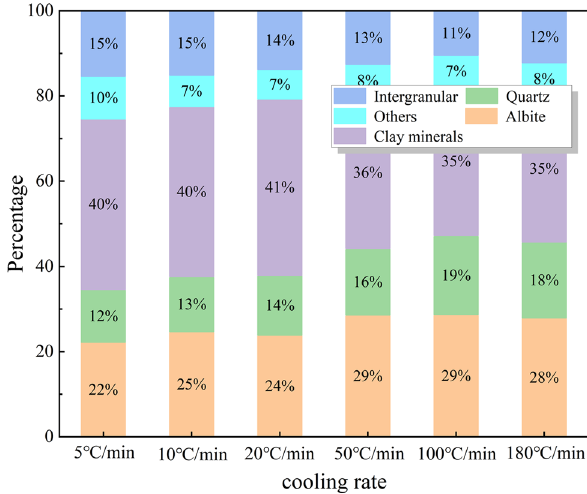
Fig. 11 Percentage of microcracks under uniaxial compression